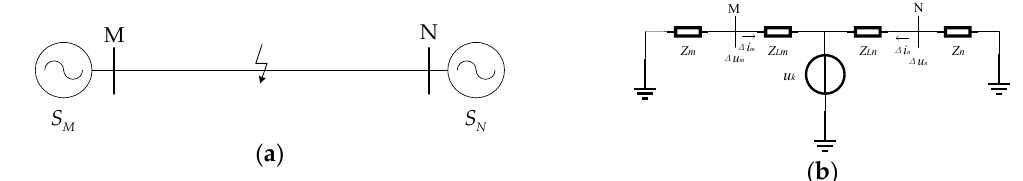
Figure 1. The traditional double-ended power system: ( a ) a diagram of the traditional double-ended power system; ( b ) the positive sequence fault additional network.